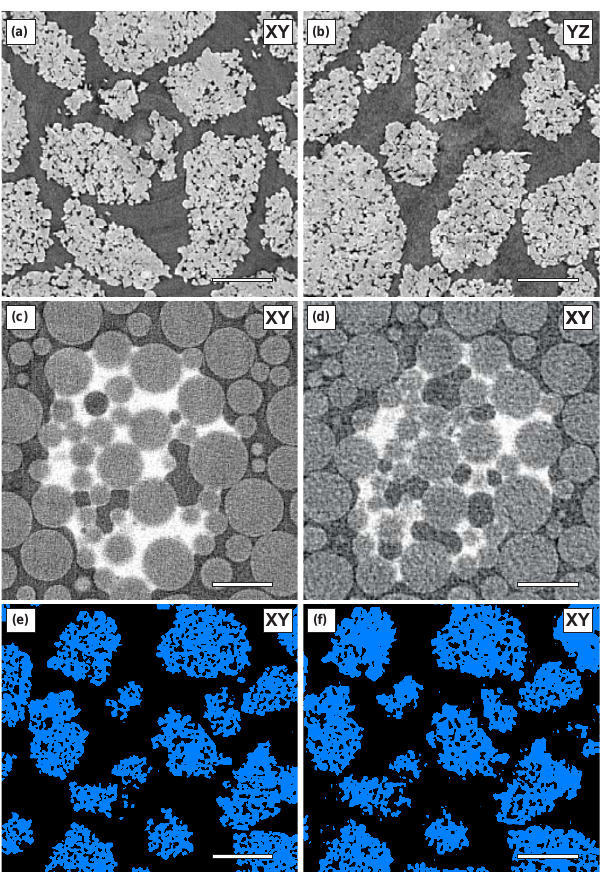
Figure 2. Two-dimensional reconstructed slices through a typical gravel sample. High-resolution (1800 projection data) perpendic- ular ( a ; XY) and parallel to flow direction ( b ; YZ) reconstructed using filtered back projection. (c) A 2-D slice (XY) through a sim- ple spherical bead pack containing a small volume for KI solution reconstructed from 360 projections (2/ ◦ ) using filtered back projec- tion; (d) the same 2-D slice reconstructed from 180 projections (1/ ◦ ) using filtered back projection; (e, f) comparison of the segmentation of the rock possible from the 1800 and 180 projection data. All scale bars are